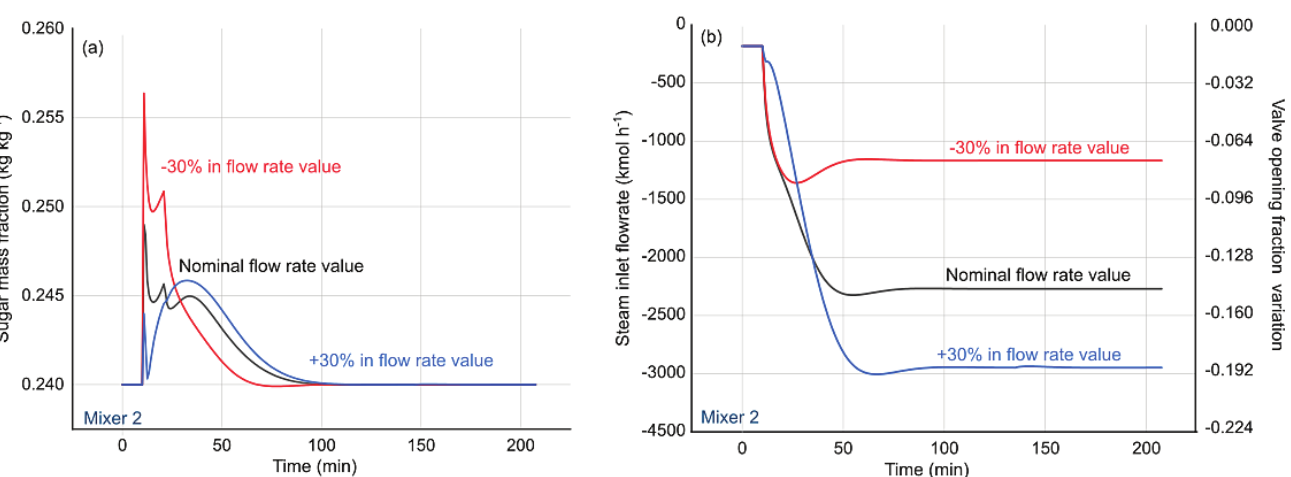
Fig. 9 – Responses of MPC controlled concentration on the second mixer to simultaneous disturbances in juice sugar concentration and temperature (a) and behavior of the manipulated valve opening and steam inlet flow rate fed to the first evaporator (b) for differ- ent values of juice flow rate